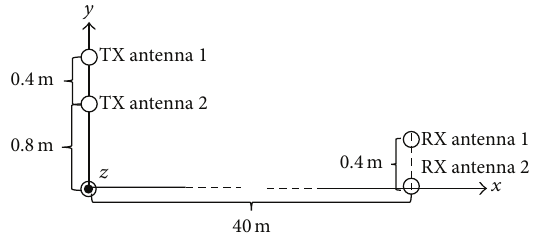
Figure 5: Photographs of experimental environments.